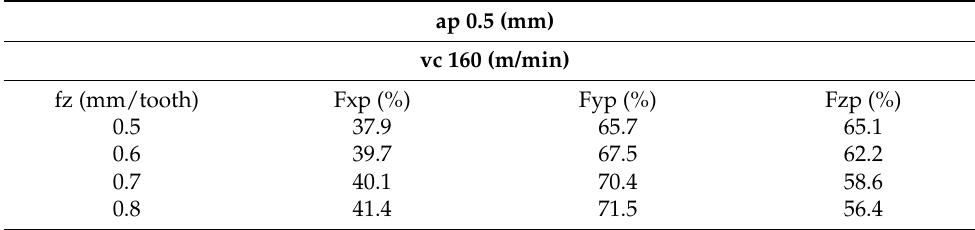
Table 6. Percentages of